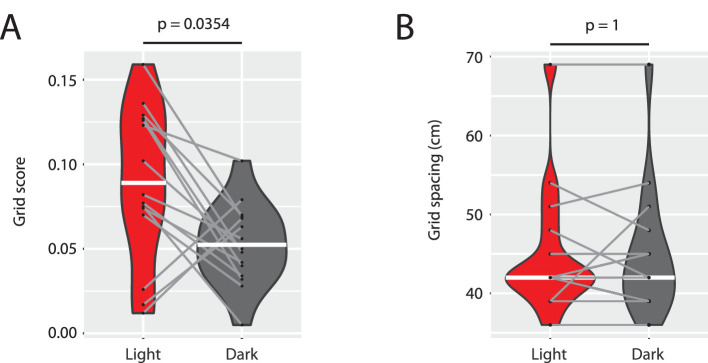
Grid scores are reduced without changes in the spacing of grid maps.(A) Grid scores computed from spike-triggered firing rate maps from the light and dark condition of the n = 15 grid cells shown in Supplementary Figure 1 related to Figure 6. (B) Grid spacing (first peak location in the radial distance plots shown in Supplementary Figure 1 related to Figure 6) for the same n = 15 grid cells in the light and dark condition. White horizontal lines indicate the median of the distribution. Gray lines connect data from the same cell. p-values from Wilcoxon signed-rank test.